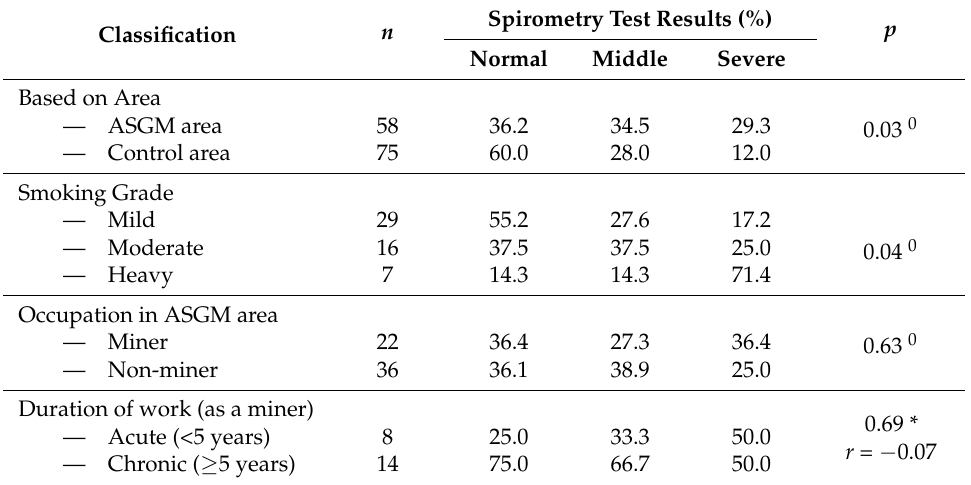
Table 3. Analysis of spirometry test results based on area, smoking grade, occupation of respondent in ASGM area, and duration of work as a miner. Spirometry Test Results (%) p Classification n Normal